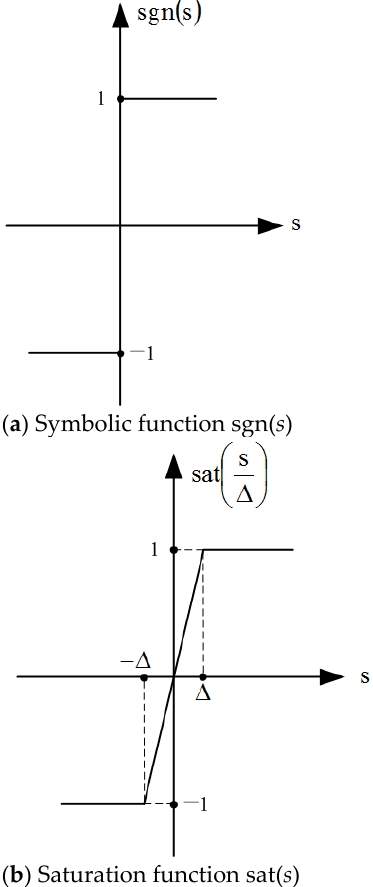
Figure 3. A comparison between the symbolic function and saturation function.